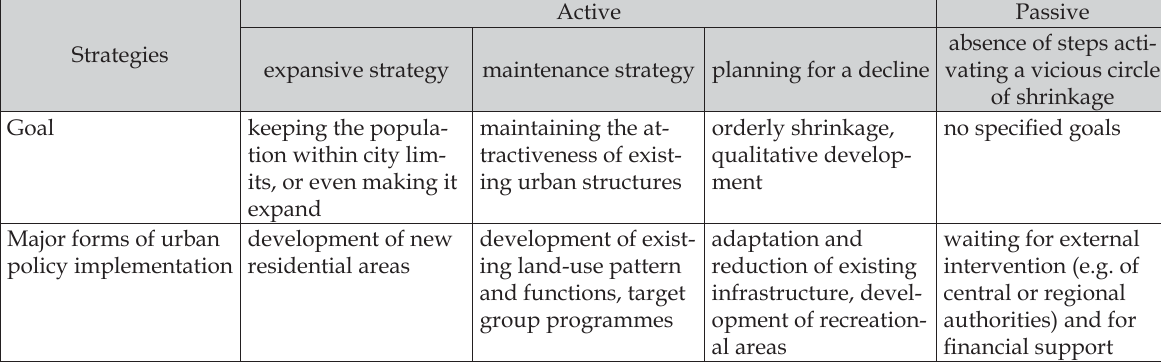
Table 2. Types of strategies designed to overcome the adverse effects of urban shrinkage.